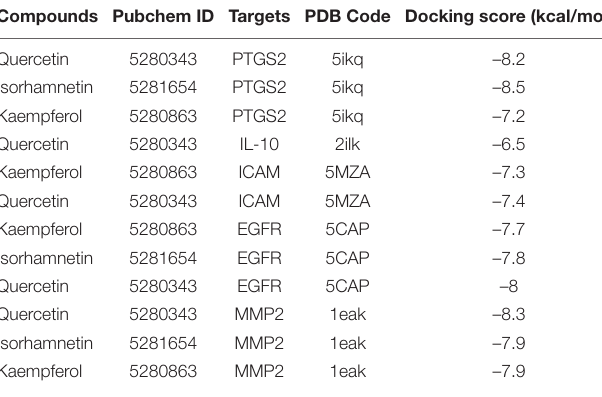
TABLE 2 | Docking scores of the active compounds of HL with their potential